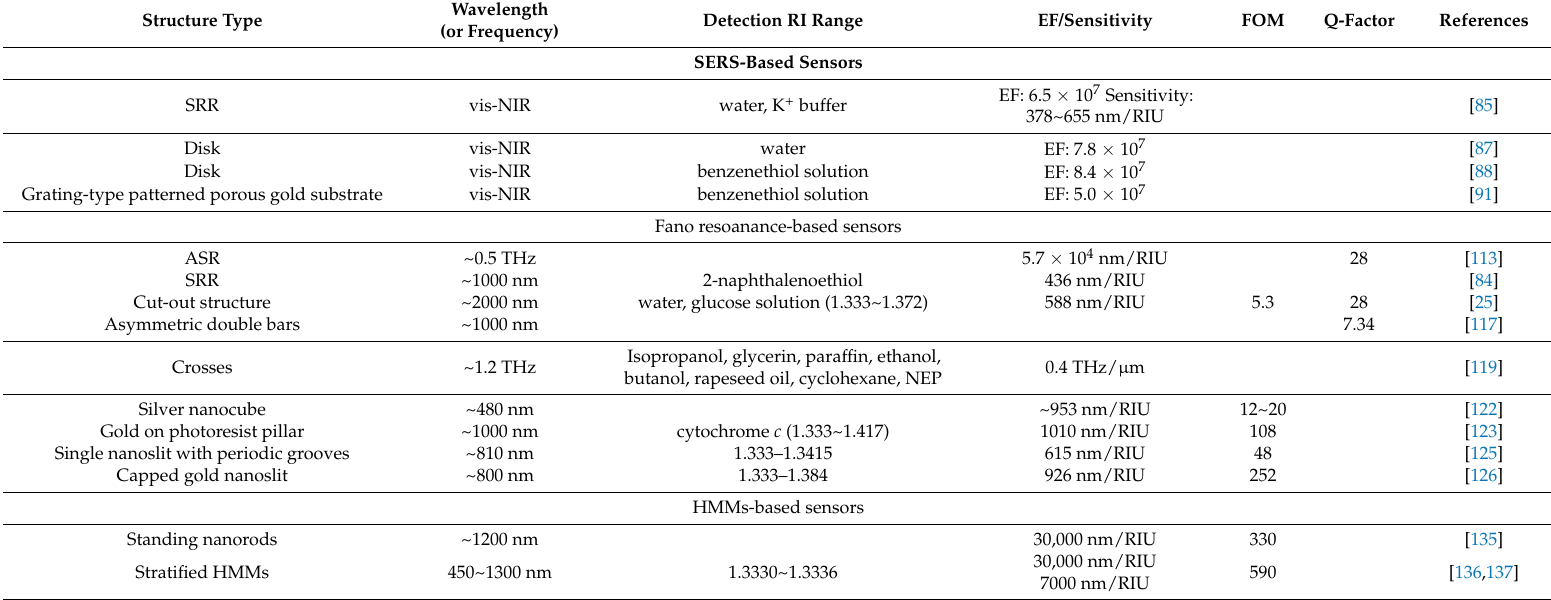
Table 2. Performance of MMs-based RI sensors.